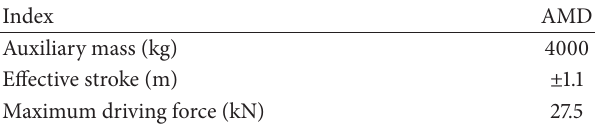
Figure 2: The plan of each floor. Table 1: Key parameters of AMD.